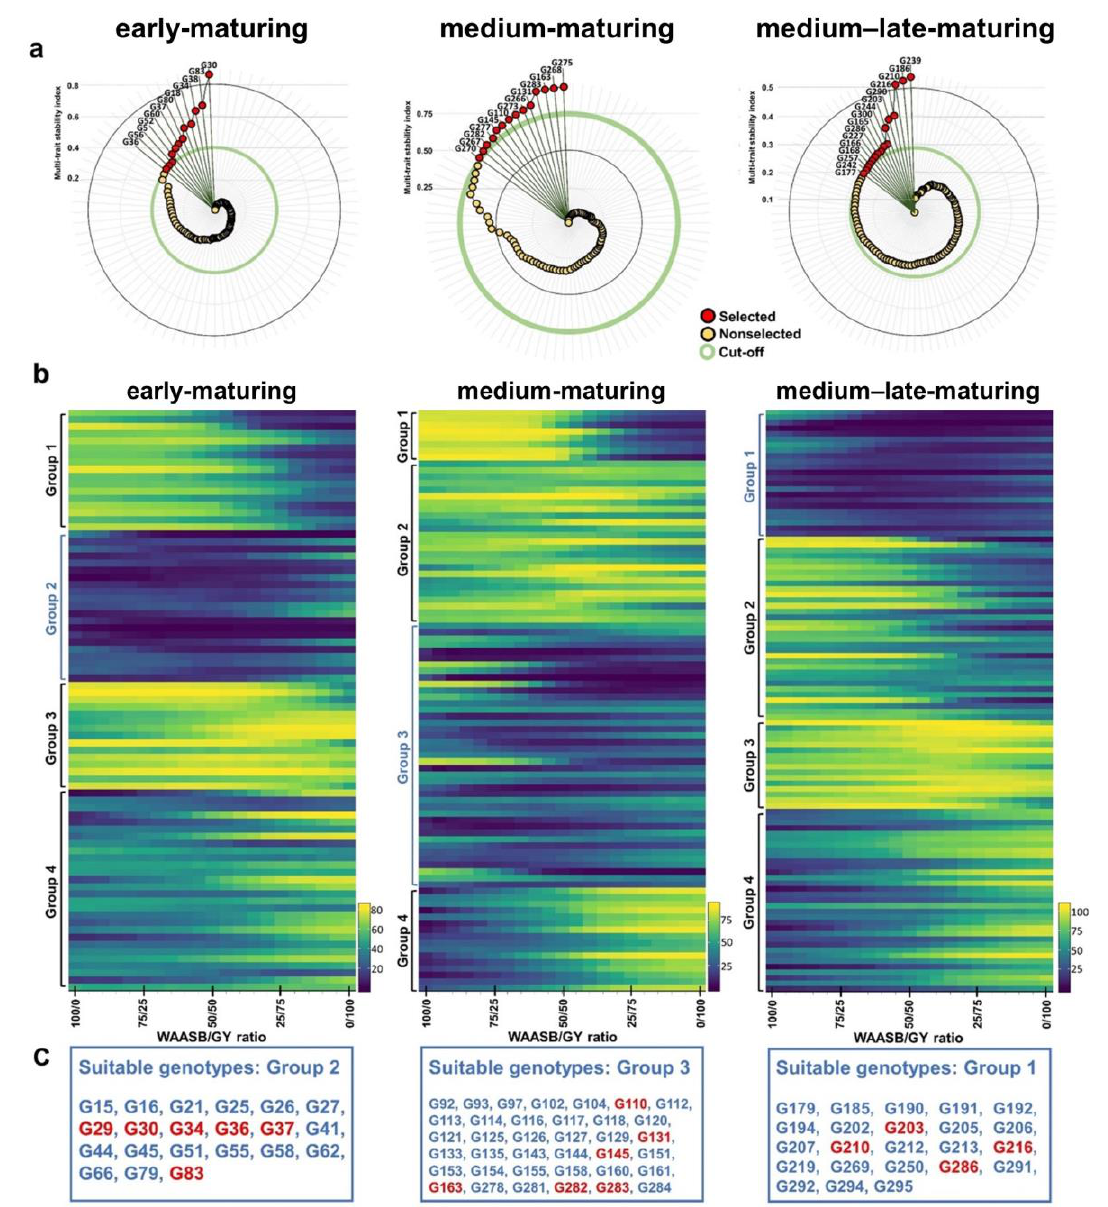
Figure 5. Grain yield and yield-related trait performance and stability across the environments. ( a ) Plot of multi-trait stability indexes (MTSI) of early-, medium-, and medium–late-maturing cultivars. Red and yellow circles indicate selected and non-selected genotypes, respectively. Green circles indicate the cut-off. ( b ) Heatmaps of the WAASBY indexes showing ranks of the genotypes according to weighting scores of grain yield and stability. ( c ) List of suitable genotypes per maturity group. Red font indicates highly ‘recommended’ genotypes.